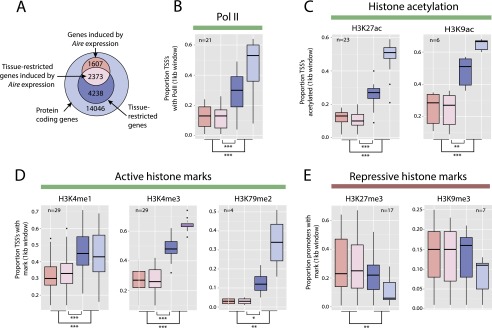
Genes induced by Aire expression are characterized by a repressive chromatin state in somatic tissues. (A) Genes were divided into sets comprising Aire expression-induced (light pink) or Aire expression-independent TRAs (dark blue), other genes induced by Aire expression (dark pink), and all other genes (light blue). The proportion of genes in each of these sets with TSS overlapping Mouse ENCODE ChIP-seq peaks in various tissue and cell types was assessed. (B) Box and whisker plots show the distribution of proportions of the four gene sets (see panel A) overlapping RNA polymerase II (Pol II) ChIP-seq calls from 21 Mouse ENCODE samples. The TSS of tissue-restricted genes induced by Aire expression overlap significantly less frequently with Pol II binding sites than those of other TRAs. A similar pattern was observed for histone acetylation (C) and active histone marks (D). In contrast, the TSS of genes induced by Aire expression show significantly greater overlap with H3K27me3 across 17 Mouse ENCODE samples (E). The n-values represent the number of Mouse ENCODE samples analyzed. (*) P < 0.05, (**) P < 0.01, (***) P < 0.001, using the Mann-Whitney U-test. Colors as in A.